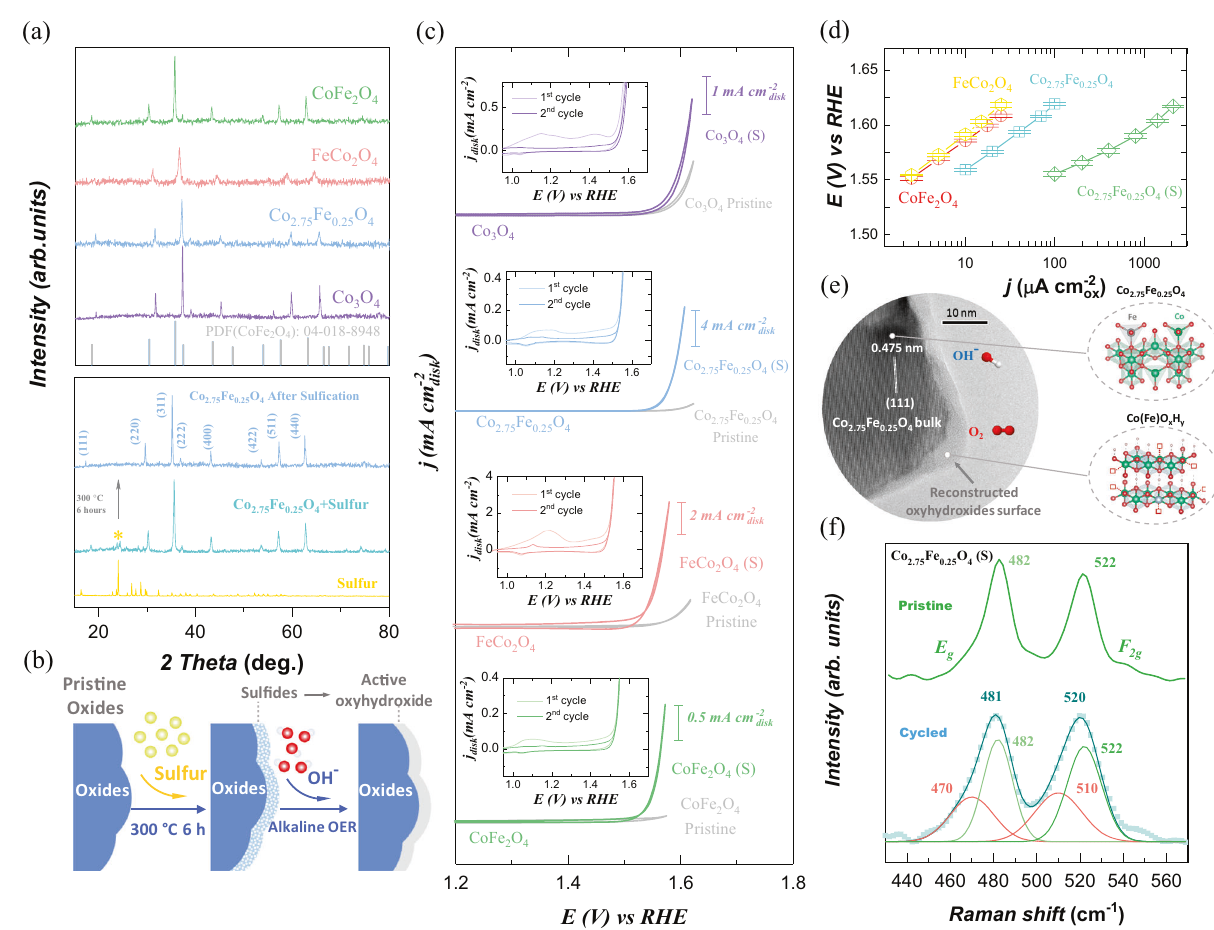
Fig. 1 Controllable surface reconstruction on Co 3 − x Fe x O 4 spinel oxides for OER. a The powder X-ray diffraction (XRD) patterns of as-synthesized Co 3 − x Fe x O 4 ( x = 0 – 2.0) (top) and Co 2.75 Fe 0.25 O 4 as selected example before and after sulfurization (bottom). b The schematic diagram of a controllable reconstruction on oxides by controlling the sulfurization. The sulfurized products are denoted as Co 3 − x Fe x O 4 (s). c The cyclic voltammetry (CV) curves of Co x Fe 3 − x O 4 ( x = 0 – 2.0) in O 2 -saturated 1 M KOH with a scan rate of 10 mV s − 1 . Inset is the fi rst and second CVs of sulfurized oxides (noted as Co 3 fi c activity of Co − x Fe x O 4 (s)). d The Tafel plots of the OER speci 2.75 Fe 0.25 O 4 (s) versus pristine Co 3 − x Fe x O 4 oxides. The plots are given after oxide surface area normalization, capacitance correction, and iR correction. The error bars represent the standard deviation from three independent measurements. e The high-resolution transmission electron microscope (HRTEM) image of Co 2.75 Fe 0.25 O 4 (s) after reconstruction (i.e., Co 2.75 Fe 0.25 O 4 /Co(Fe)O x H y ). The HRTEM sample is from the electrode that was cycled without adding carbon. The bulk Co 2.75 Fe 0.25 O 4 oxide is covered by an amorphous (oxy)hydroxide layer with thickness of ~4 nm. f The Raman spectra of Co 2.75 Fe 0.25 O 4 (s) before and after operating under OER. The peaks at Raman shift of 482 and 522 cm − 1 are assigned to E g and F 2g mode in Co 2.75 Fe 0.25 O 4 spinel. The broad peaks at Raman shift of 470 and 510 cm − 1 are resulted by the bending